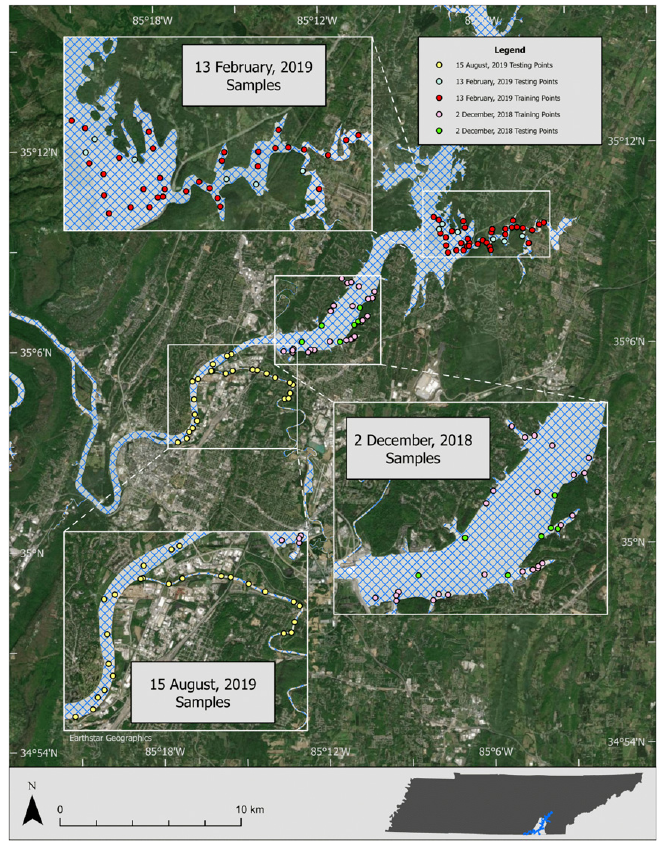
Figure 6. Map showing the locations of in situ turbidity samples collected on each of the three dates, separated into the sample points used for training and testing the